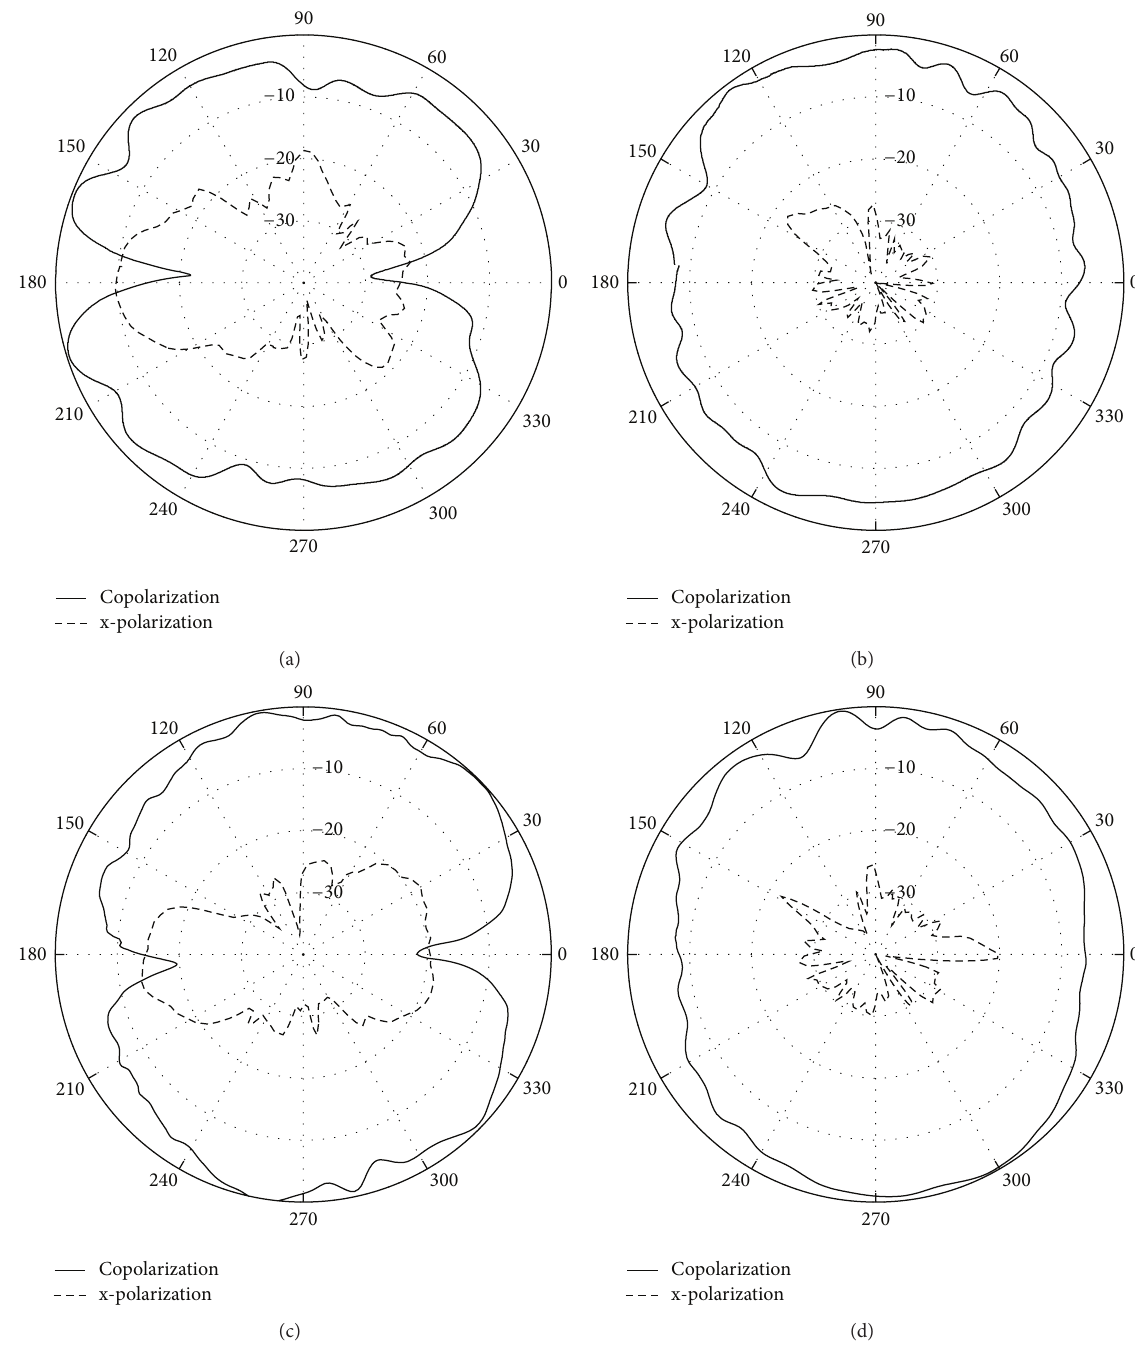
Figure 7: Measured normalized radiation patterns in YOZ plane and XOZ plane at two different frequencies: (a) YOZ plane at 4 GHz; (b) XOZ plane at 4 GHz; (c) YOZ plane at 8GHz; (d) XOZ plane at 8GHz.